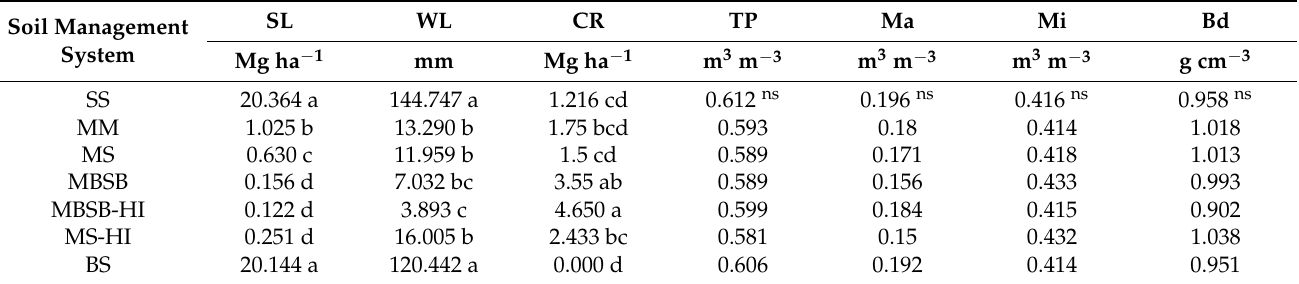
Table 1. Soil losses, water losses, cover rate, total porosity, macroporosity, microporosity, and bulk density for each treatment evaluated.